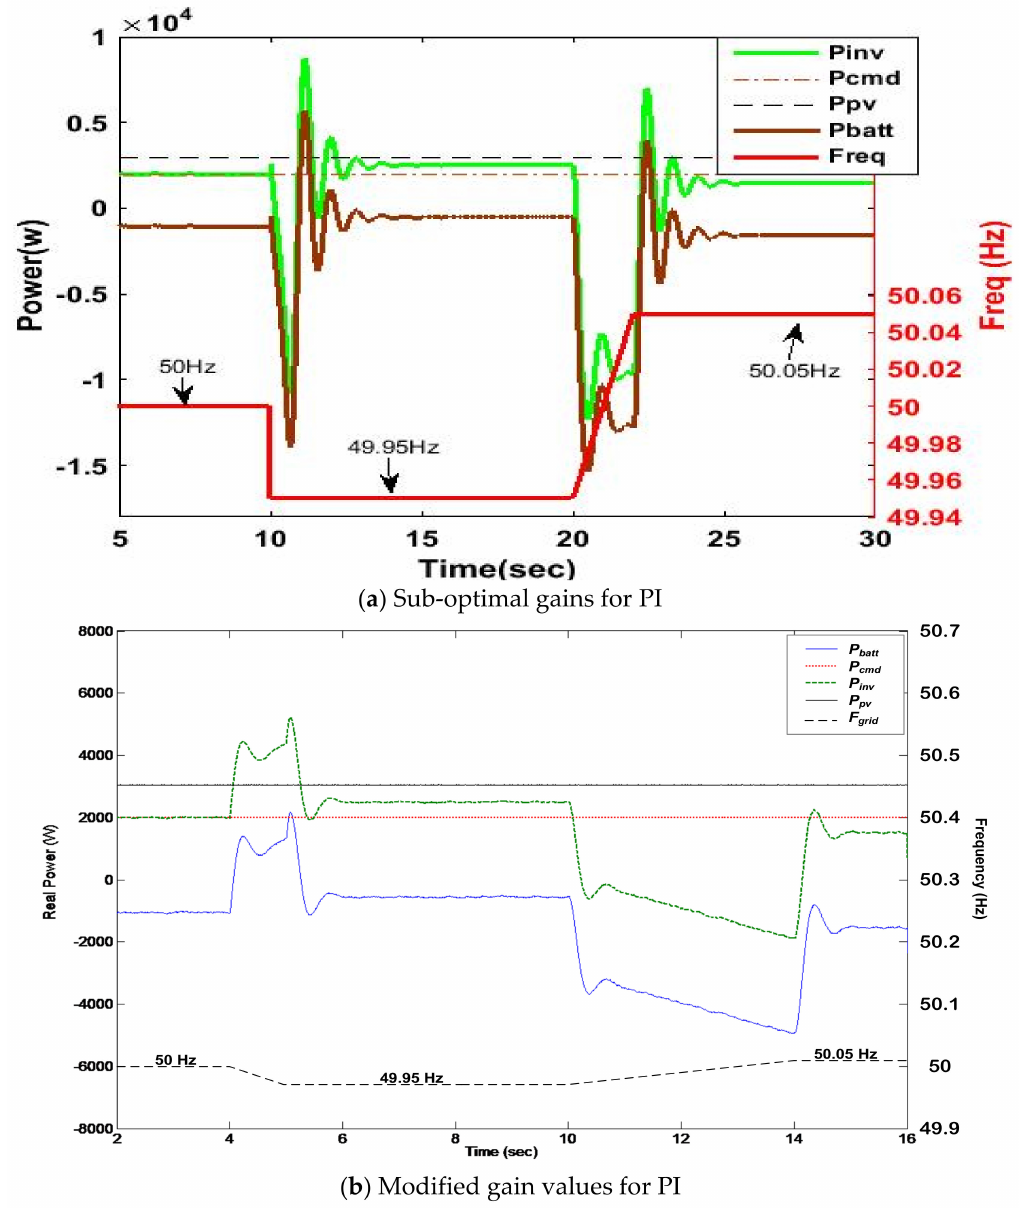
Figure 5. Operation of proposed system to provide frequency support. ( a ) Study 1 with set of values for controller; ( b ) study 2 with modified controller